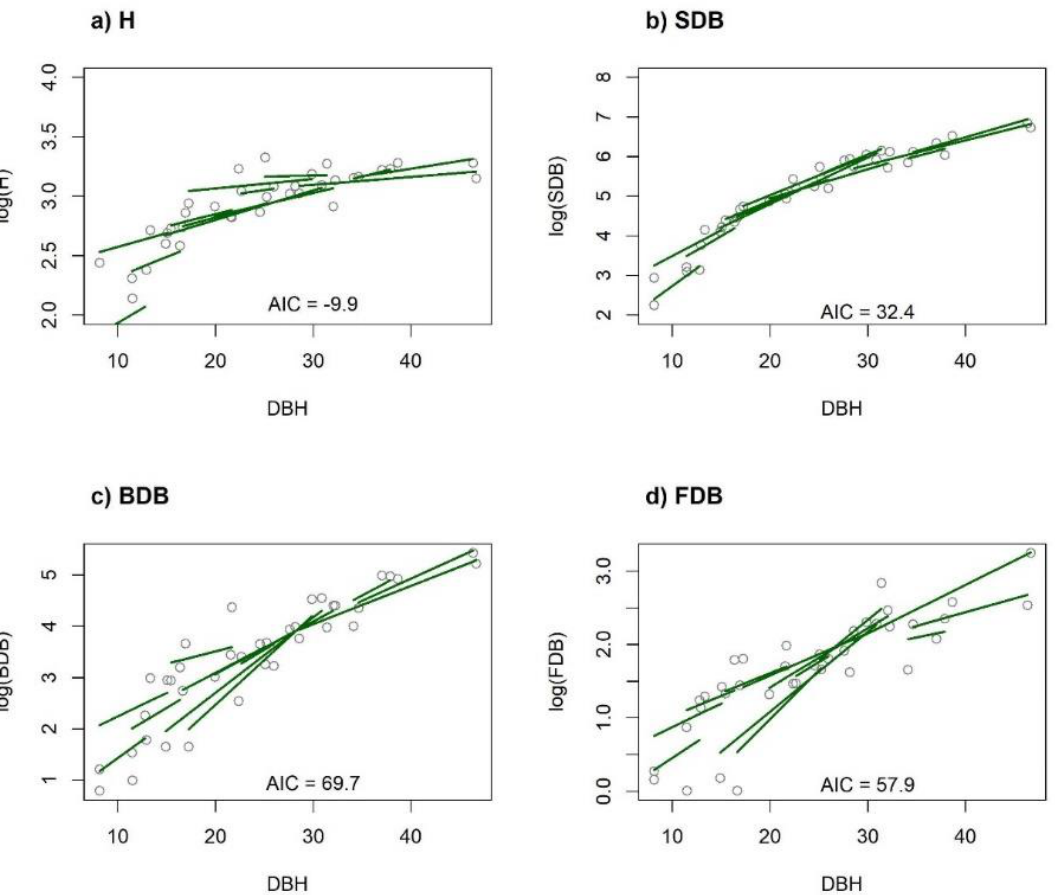
Figure 2. Individual mixed-effect models (first approach) for height (H, ( a )), stem dry biomass (SDB, ( b )), branches dry biomass (BDB, ( c )), and foliage dry biomass (FDB, ( d )) as dependent variables with diameter at breast height (DBH) as independent variable.